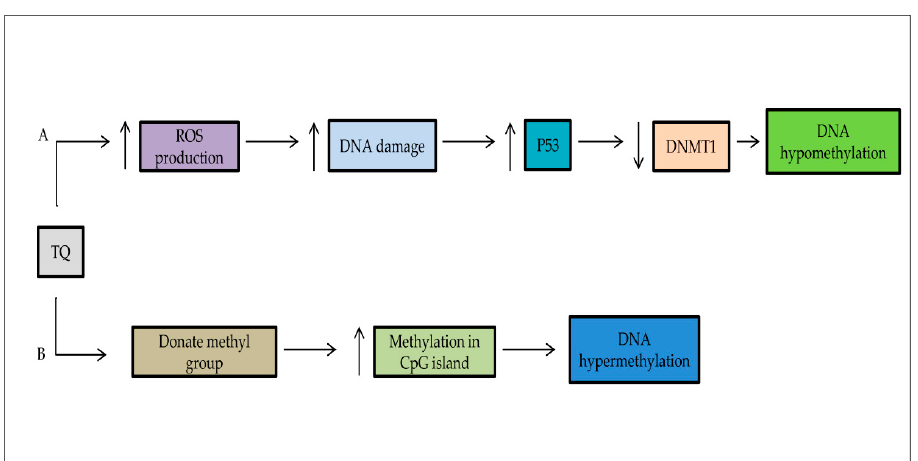
Figure 3. The double action of TQ on DNA methylation. ( A ) TQ has the potential to repair the epigenetic aberrations in cancer cells and upregulation of tumor suppressor genes such as p53, p73. It leads to the downregulation of DNA methyltransferase DNMT1. ( B ) TQ can methylate the CpG islands of genomic DNA.